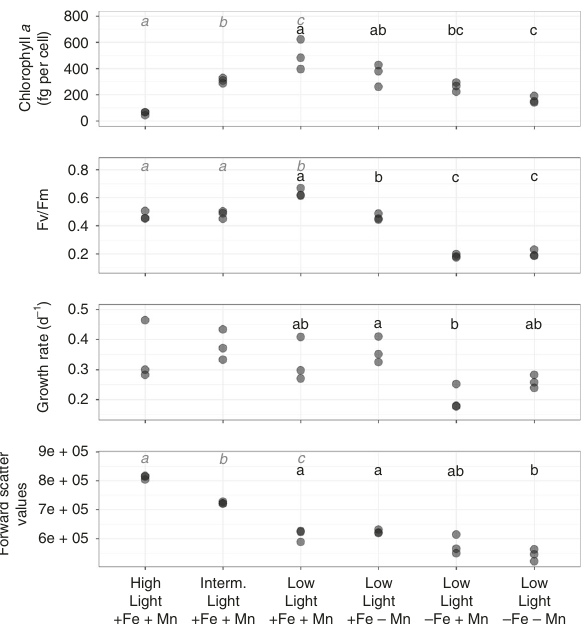
Fig. 1 Phaeocystis antarctica physiological changes. Physiological response of P. antarctica to variability in light, Mn, and Fe. High light (HL) was 230 µ E/ m 2 /s 1 , intermediate (IL) was 70 µ E/m 2 /s and low (LL) was 25 µ E/m 2 /s. Each dot represents the value measured in one biological replicate for either chlorophyll per cell, Fv/Fm, growth rate, or forward side scatter — a fl ow cytometry-derived parameter that scales with cell size. Differences between physiological response were analyzed via analysis of variance Letters denote signi fi cant differences in two separate tests: metal replete with different light levels (italics, gray, columns 1, 2, 3), and low light with different metal concentrations (columns 4, 5, 6, 7). If the ANOVA indicated signi fi cant differences in means across treatments, pairwise differences were tested for and visualized with different letters above each treatment: treatments that have the same letter are not signi fi cantly different. n = 3 biologically independent samples per treatment. Source data are